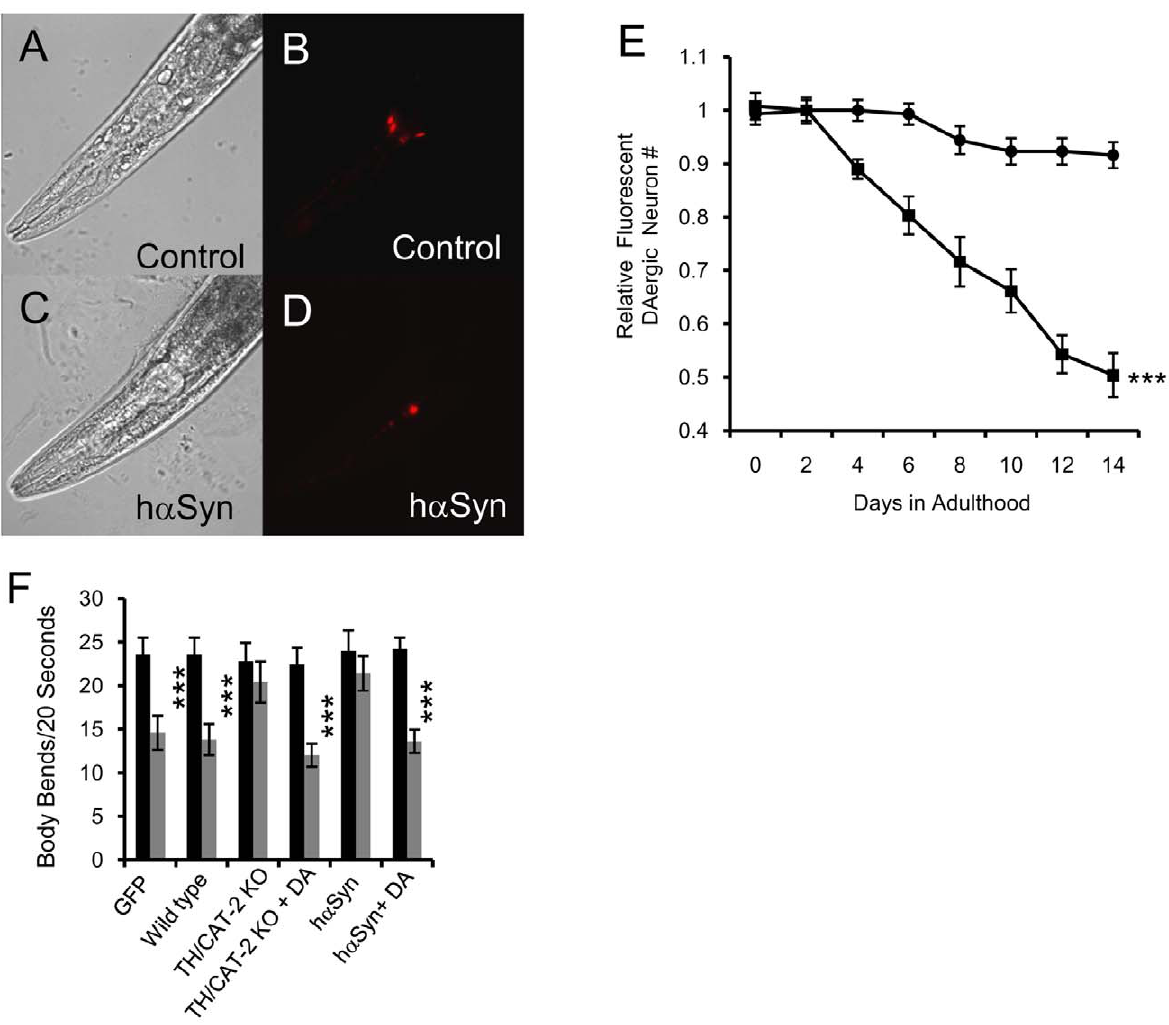
Figure 1. h a Syn expression leads to DAergic neuron degeneration. A–D, Confocal images of living day 10 adult control (AB) or h a Syn- expressing (CD) worms with DAergic neuron specific expression of DsRed. A and C, Bright field; B and D, DsRed. E, Number of fluorescent DAergic neurons in h a Syn-expressing (squares) and control (circles) lines. ***, p , 0.005 (two-way ANOVA). Error bars represent the SEM (standard error of the mean) for three independent experiments. In each experiment, the n of each sample varied from 20 to 50. F, Basal slowing response of day 2 adult worms. TH/CAT-2 KO or cat-2 is a TH/CAT-2 knockout (KO) worm line. GFP indicates a wild type line expressing GFP in DAergic neurons. Food response experiments were conducted with (grey bars) or without (black bars) food. ***, p , 0.0001 (t-test); n varied from 6 to 20. Error bars indicate SEM.